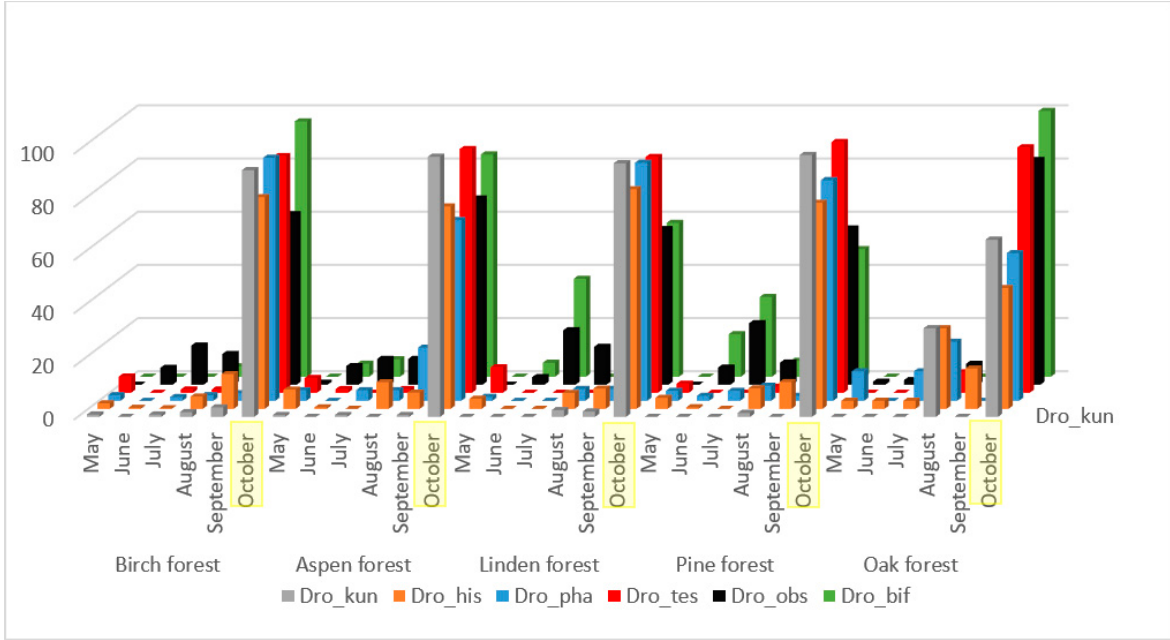
Figure 2. Dynamics of changes in the number of species D. obcura, D. bifasciata, D. histrio, D. kuntzei, D. phalerata, D. testacea from May to October as a percentage of the total number for the entire period of accounting in biotope.